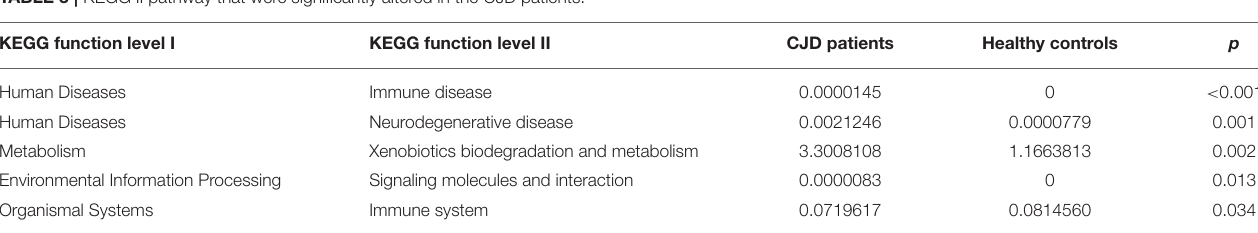
TABLE 3 | KEGG II pathway that were significantly altered in the CJD